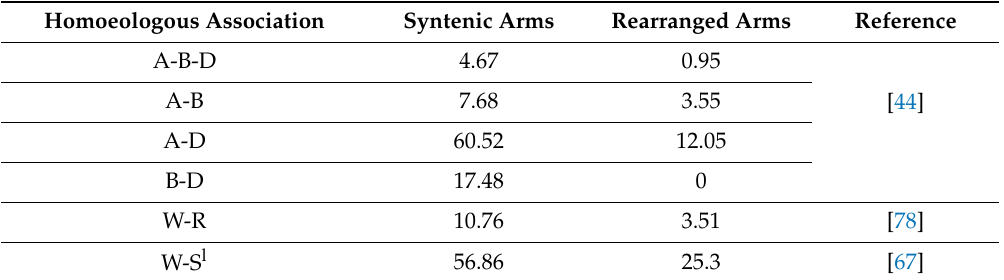
Table 1. Average frequency (%) of association at metaphase I between syntenic and rearranged homoeologous arms in hybrids of the ph1b mutant wheat (W) with rye (R) or Ae. longissima (S l ).